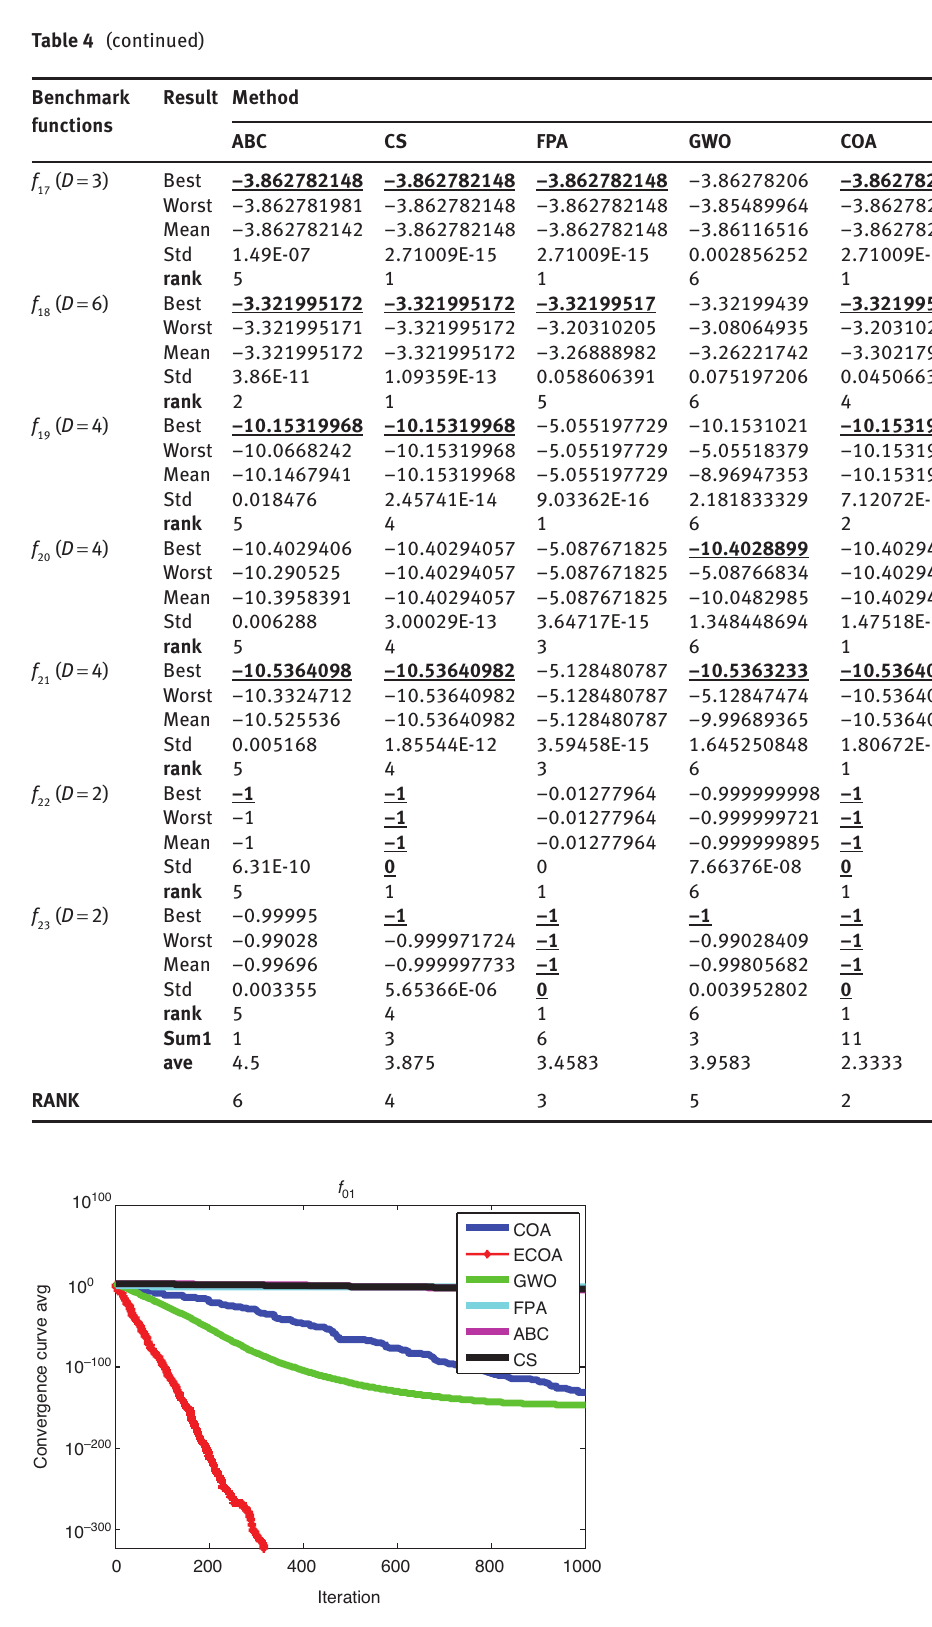
Figure 1: D = 30, Evolution Curves of Fitness Value for f